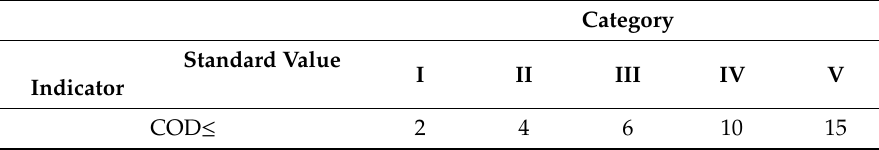
Table A2. Environmental Quality Standards for Surface Water GB3838-2002 (mg / L) (Q 3